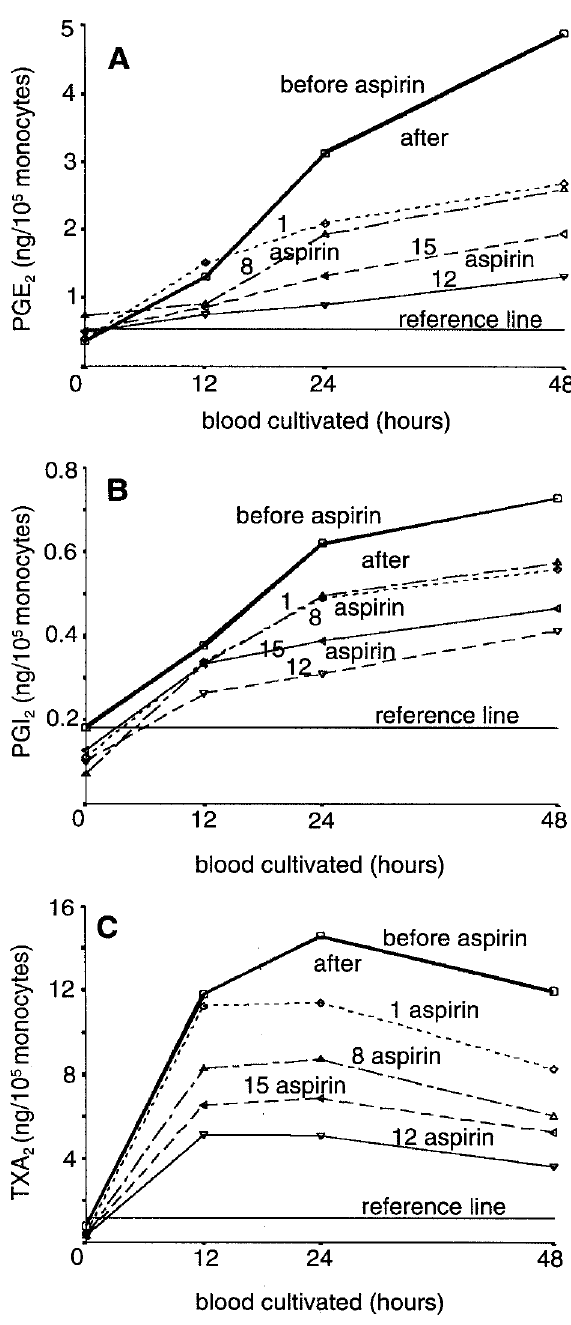
FIG. 5. The effect of a daily intake of 80mg aspirin on the release of prostanoids from lipopolysaccharide (LPS)-stim- ulated blood cultures from a healthy woman. Subject 9 ingested 80mg aspirin for 15 consecutive days. Blood was sampled immediately before (day 1) and after aspirin intake on days 2, 9, 13 and 16. Monocytes in blood samples were determined by differential leukocyte count- ing with a Cysmex NE 8000. LPS-stimulated blood cultures without and with the cyclooxygenase-2 inhibitor DFU (10 m M in dimethylsulfoxide) were prepared, prostanoids extracted from blood culture supernatants by absorption on C 18 cartridges and eluation with absolute ethanol, and determined by immunoassays. Values for (A) prosta- noid E 2 (PGE 2 ), (B) prostanoid I 2 (PGI 2 ), and (C) thrombox- ane A 2 (TXA 2 ) were calculated as nanograms per 10 5 monocytes. Concentrations of prostanoids in blood cul- tures with DFU were all below the indicated reference